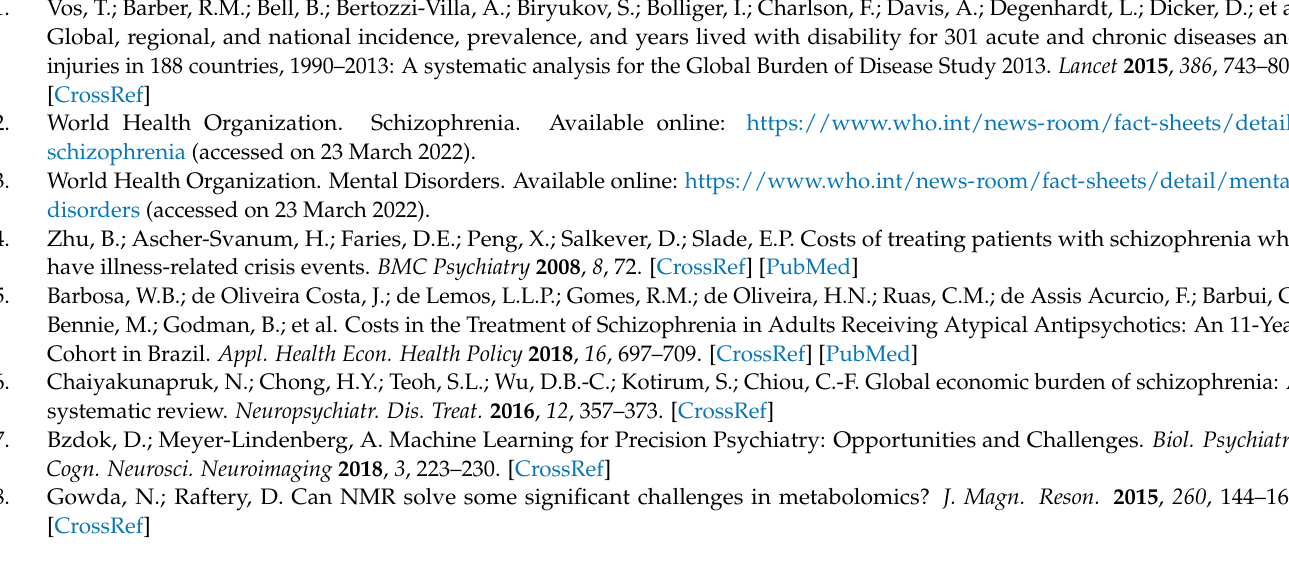
(a) Scores plot of PCA model presented in PC 1 vs. PC2 components. Scaling and centering were accomplished with autoscaling; (b) Corresponding loading plot of PC 1 component.; Figure S5: (a) Y Predicted for the class ‘Schizophrenia’ and (b) Y Predicted for the class ‘Control’ from external test data set, using autoscaling; Figure S6: Fractional Y-variance captured for self-prediction (calibration) and cross-validation versus the correlation of the permuted Y-block to the original Y-block for 4 LV component models of (a) OPLS-DA model using autoscaling and (b) OPLS-DA model using class centroid centering and